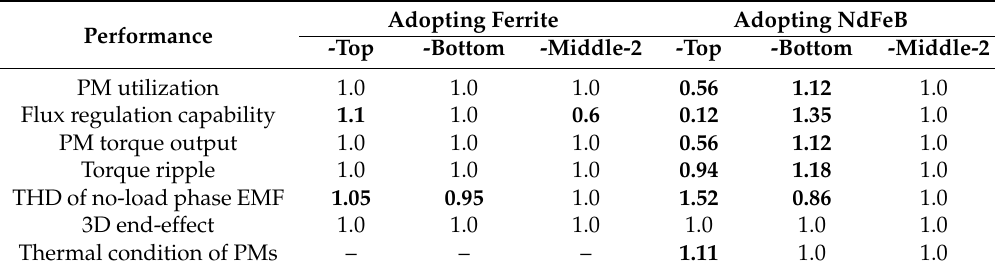
Table 9. Quantitative evaluations in per-unit/proportion